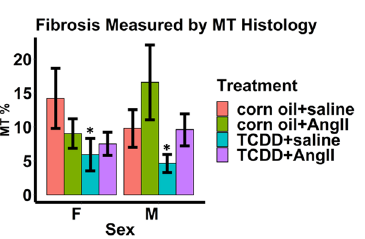
Figure 7. Fibrosis measured by Masson’s Trichrome (MT) staining in hearts obtained from 14-month old mice. Two weeks after osmotic pump implantation surgery, hearts were formalin-fixed, routinely processed, paraffin embedded, and cut into 6-µm sections, and individually stained MT. Ten non-overlapping photomicrographs were taken for each mouse and then randomized before analysis. MT-positive quantification was performed via color based thresholding assisted by ImageJ (NIH) to determine the percentage of MT positive tissue indicative of fibrosis (% positive index). Values are mean + SE. * p < 0.05 using Welch two-sided t-test comparing saline to Ang II by each sex and either corn oil or TCDD. # p < 0.05 using Welch two-sided t-test comparing TCDD to corn oil by each sex and either saline or Ang II. Corn oil + Ang II: n = 6 females, 7 males; Corn oil + saline: n = 4 females, 4 males; TCDD + Ang II: n = 7 females, 7 males; TCDD + saline: n = 6 females, 7